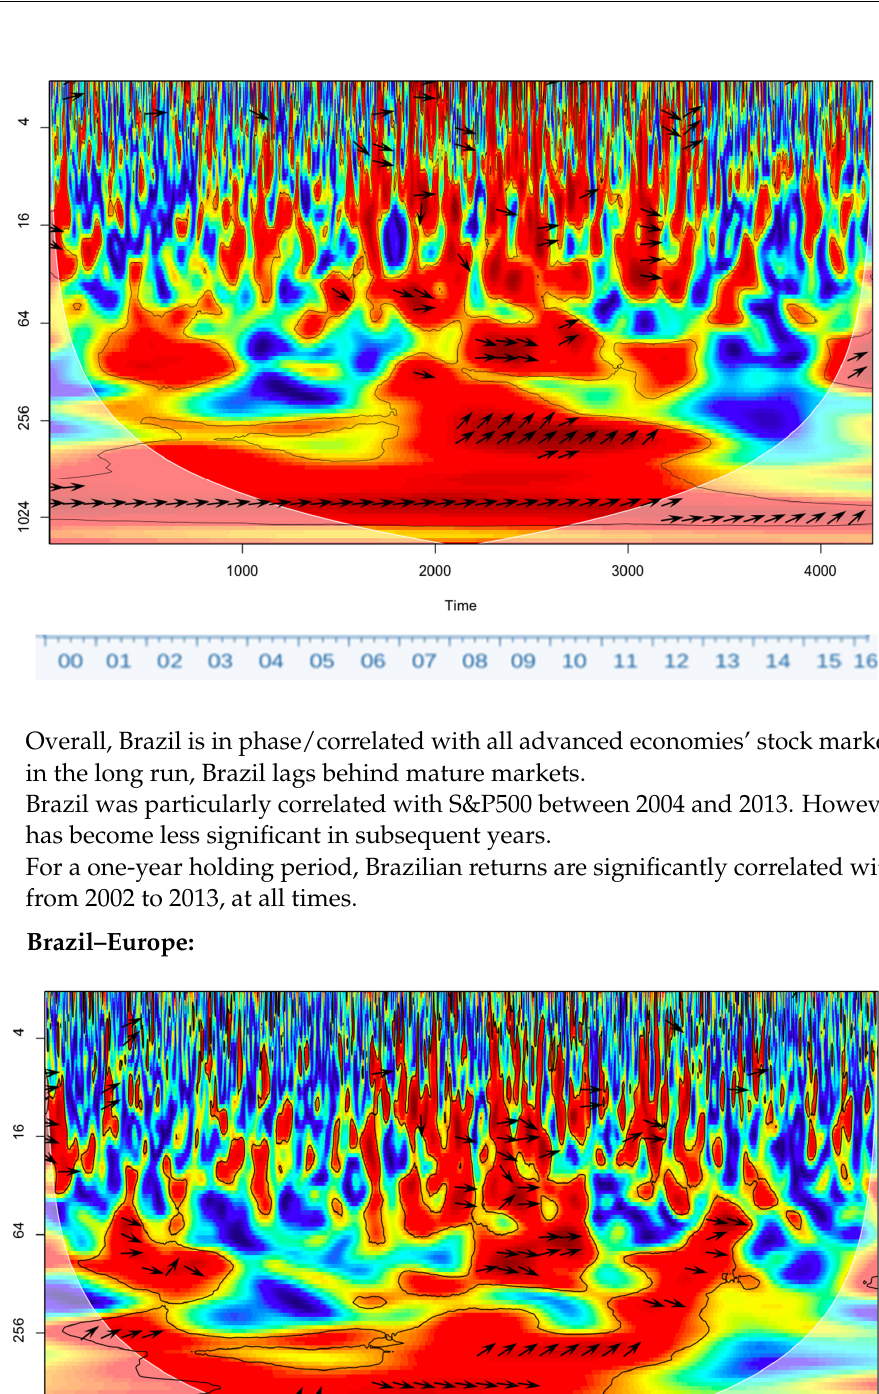
22 of 31 Appendix B. Charts for Continuous Wavelet Time–Frequency Interpretation Key: The horizontal axis shows calendar time. The vertical axis represents the time period studied/Holding Period. The thick black line represents a 5% significance level estimated from the Monte Carlo simulation. The cone of influence, which represents areas influ- enced by border effects, is shown with a white line. Regions of differing power are repre-